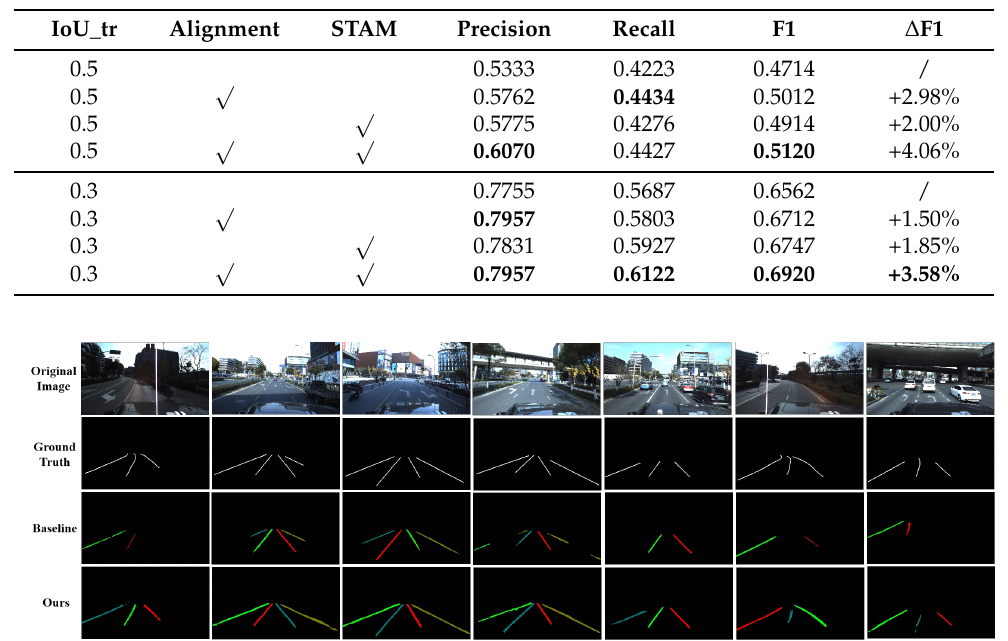
Table 8. Effectiveness study results on ApolloScape. Here, the number of input frames is set 2.